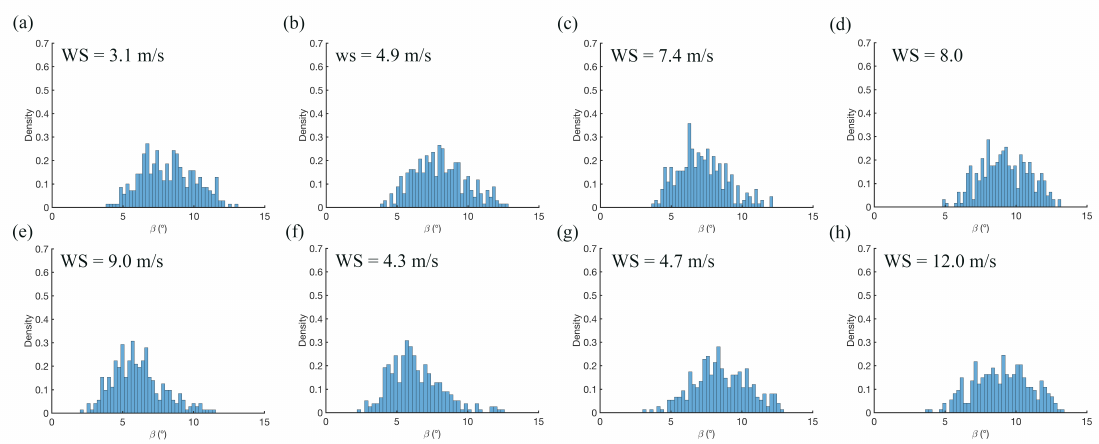
Figure 4. Normalized β histograms, evaluated over the homogeneous sea surface ROIs. The figure is organized in a matrix format. Rows refer to: AP ( a – d ); and RS ( e – h ) SAR sensors. Columns refer to the AOI: ( a , e ) low (22–27 ◦ ); ( b , c , f , g ) intermediate (31–35 ◦ ); and ( d , h ) high (38–42 ◦ ). The corresponding mean WS values are also